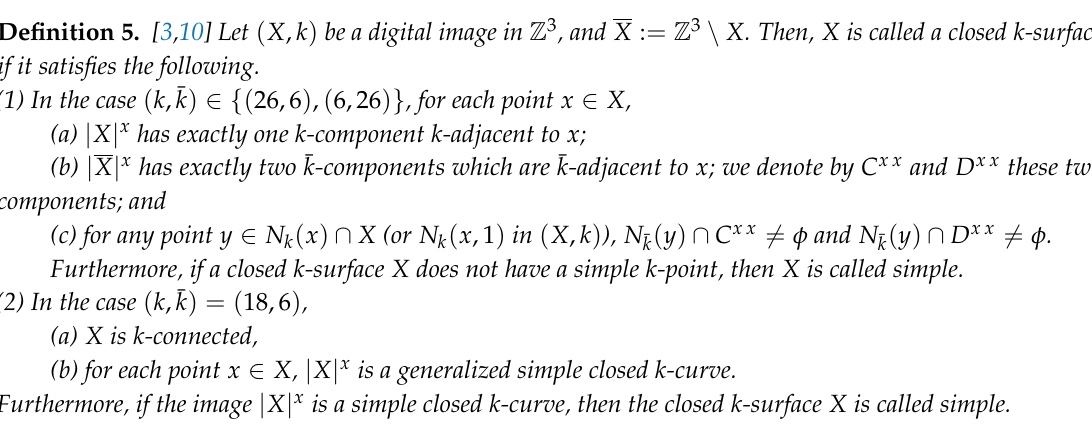
Figure 2. ( a ) MSS 18 [5,6]: ( b ) MSS (cid:48)